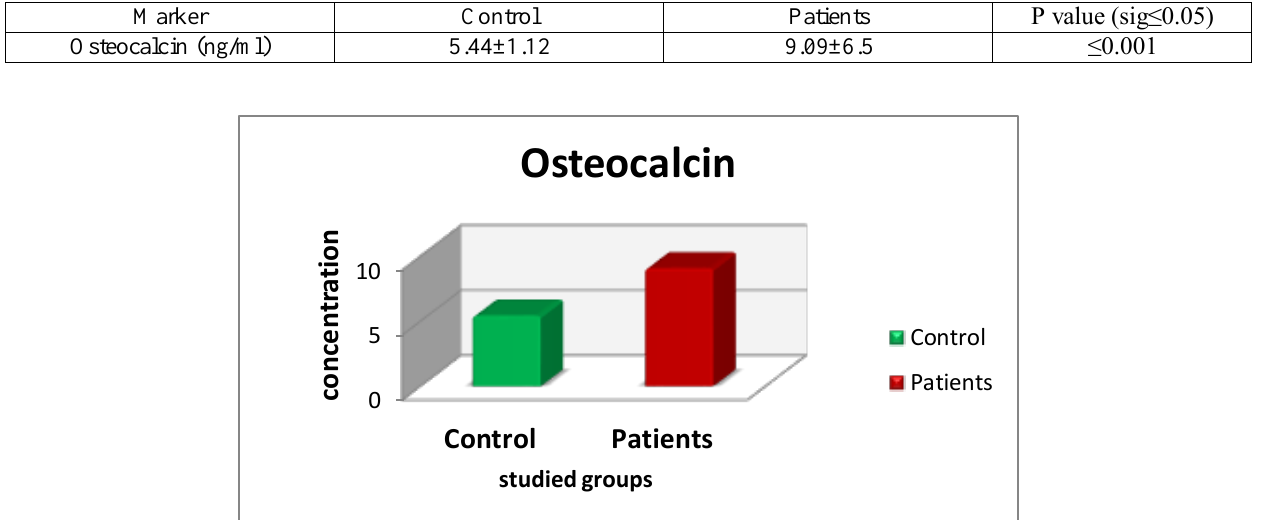
Table 5: Level of serum osteocalcin in patients and control groups.